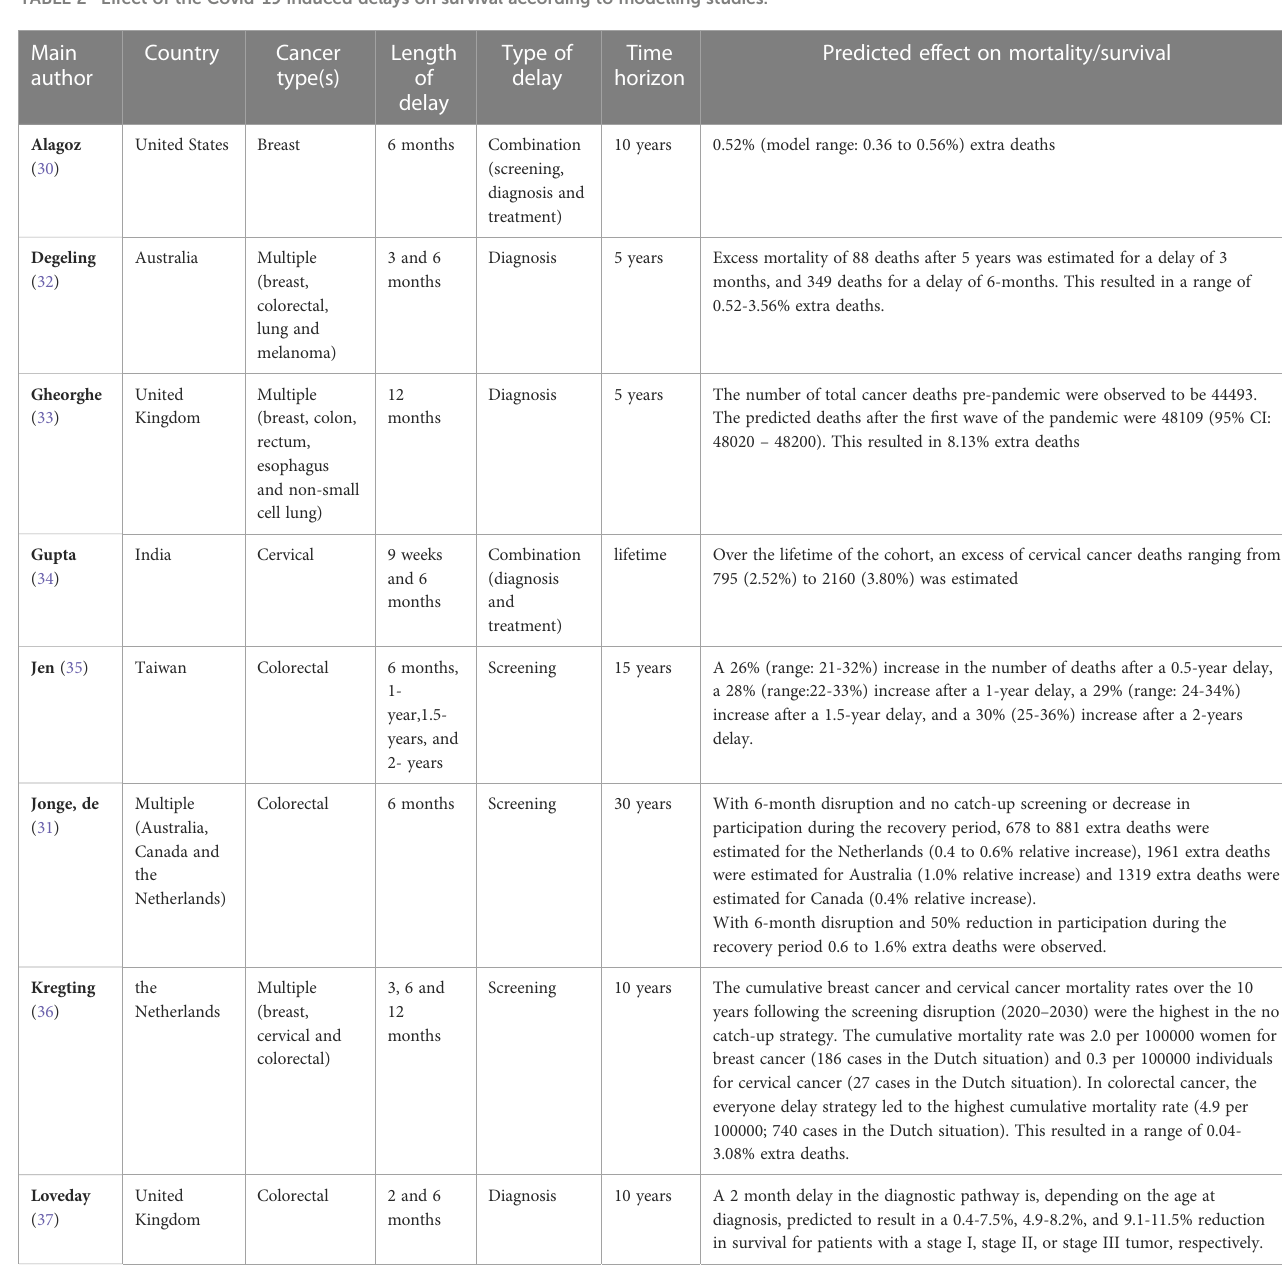
recovery period 0.6 to 1.6% extra deaths were